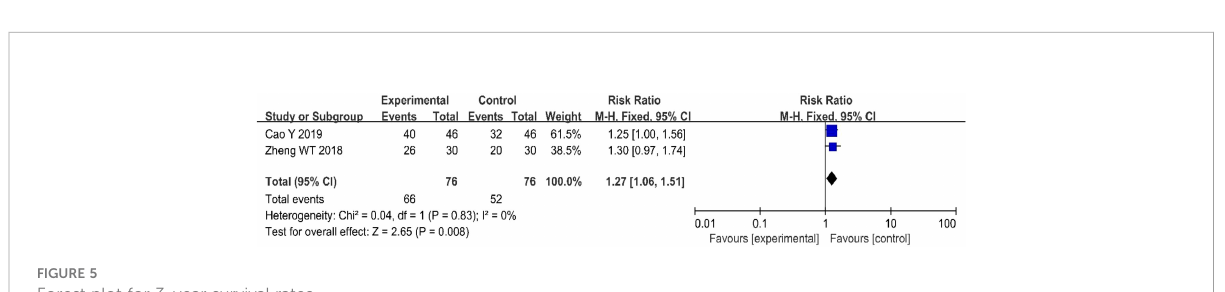
FIGURE 5 Forest plot for 3-year survival